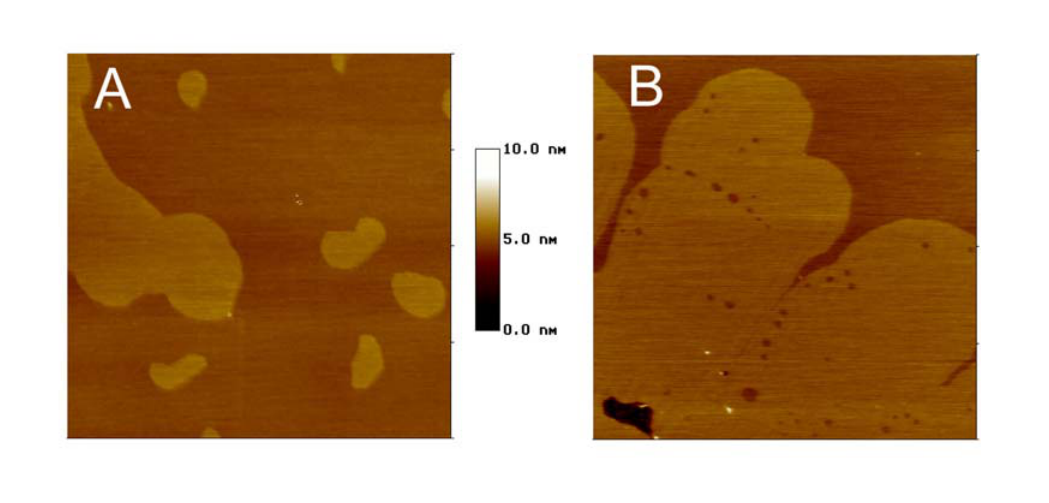
FIGURE 6 . Imaging of supported bilayers made by vesicles fusion. Phase separation in 1:1 DOPC/DPPC (A) and 1:1 DOPC/SM (B) bilayers examined in phosphate buffer (scan size 4 × 4 µm).